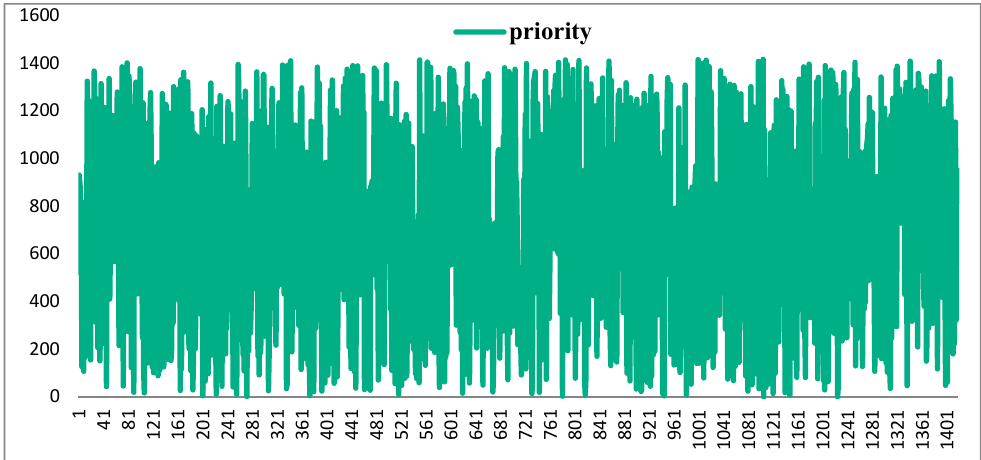
Figure 12. Difficulty of every slot allocation while weights set as [0,0.5,0.5] in test 8.